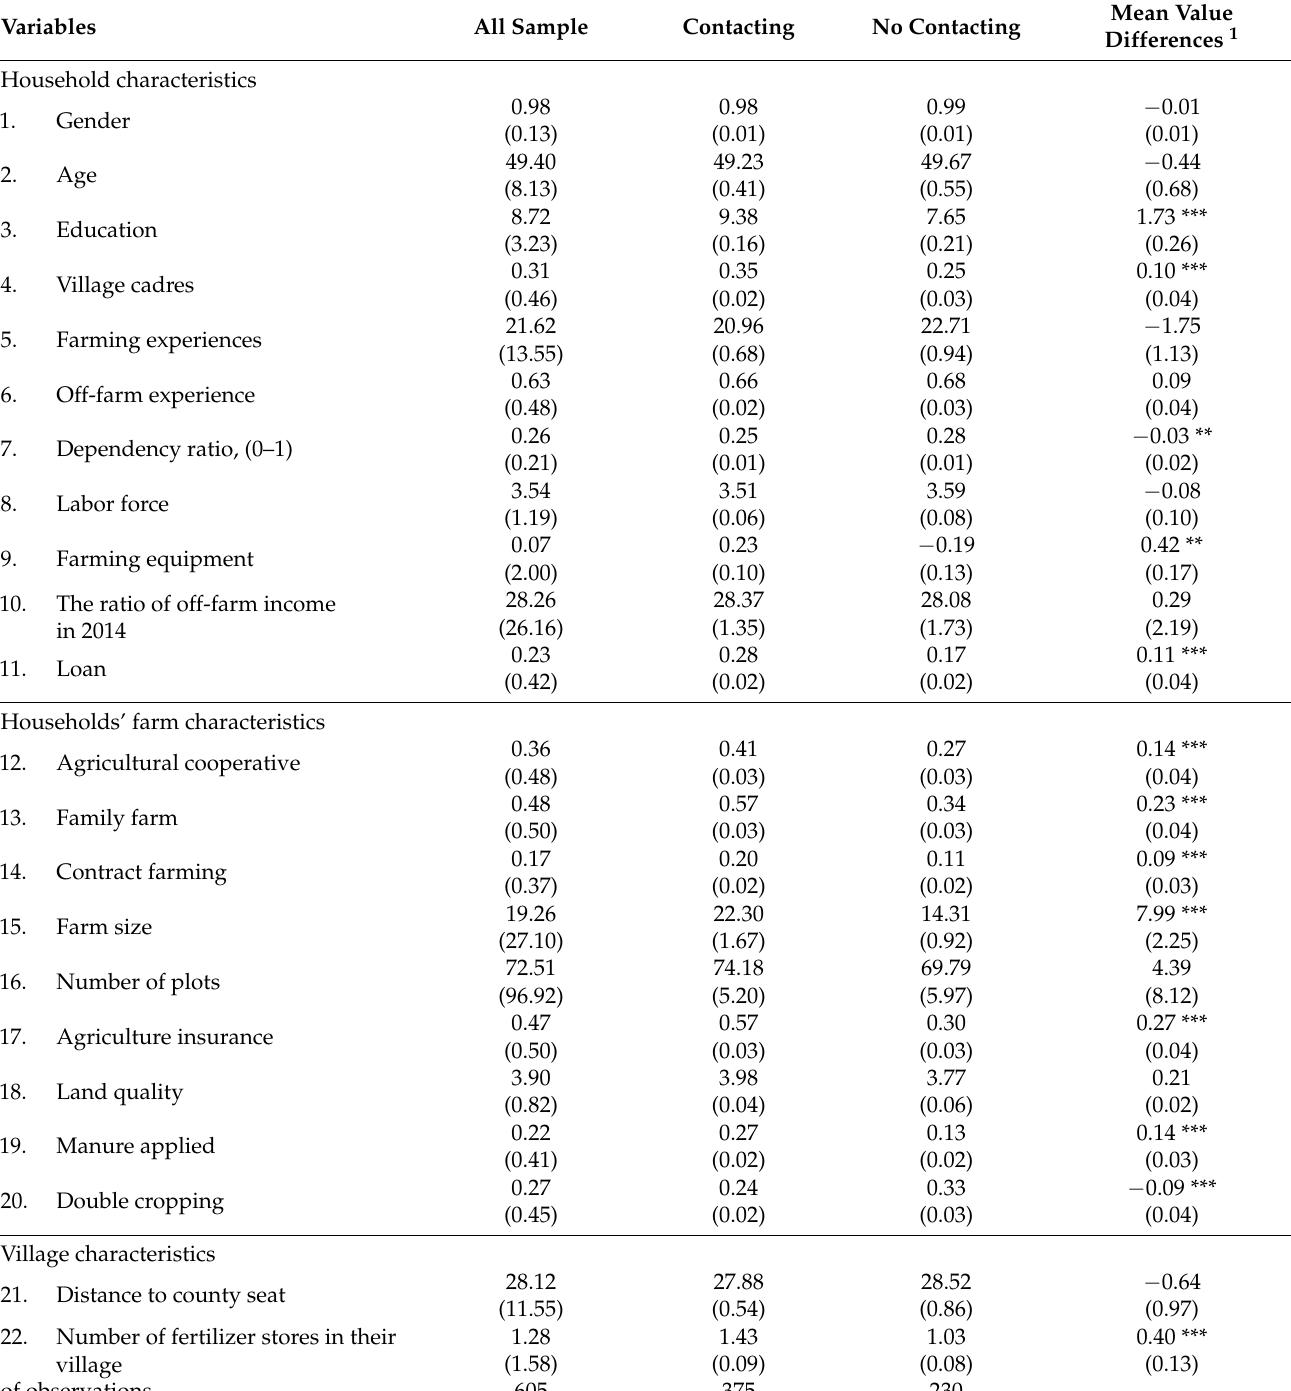
Table 3. Summary statistics for LSFs contact with extension service (treatment) and LSFs with nocontact